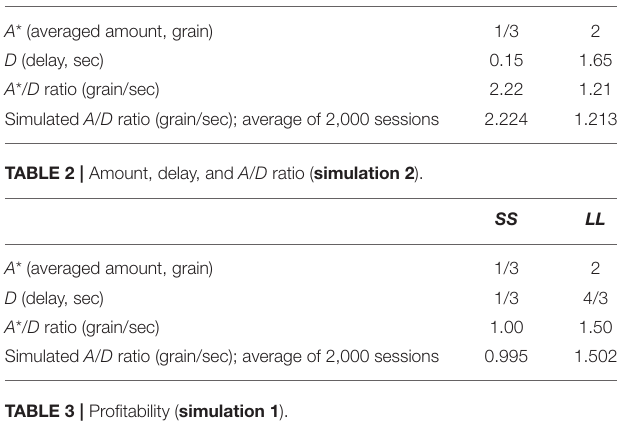
TABLE 3 | Profitability ( simulation 1 ).